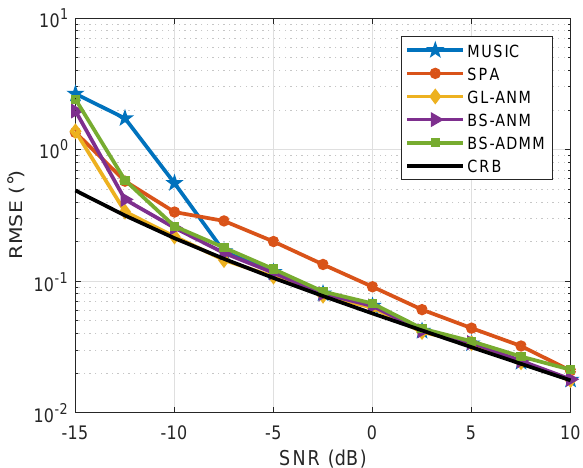
Figure 4. RMSE comparison for uncorrelated sources at θ = 5 ◦ and θ = − 10 ◦ , J = 200 when SNR varies from − 15 to 10